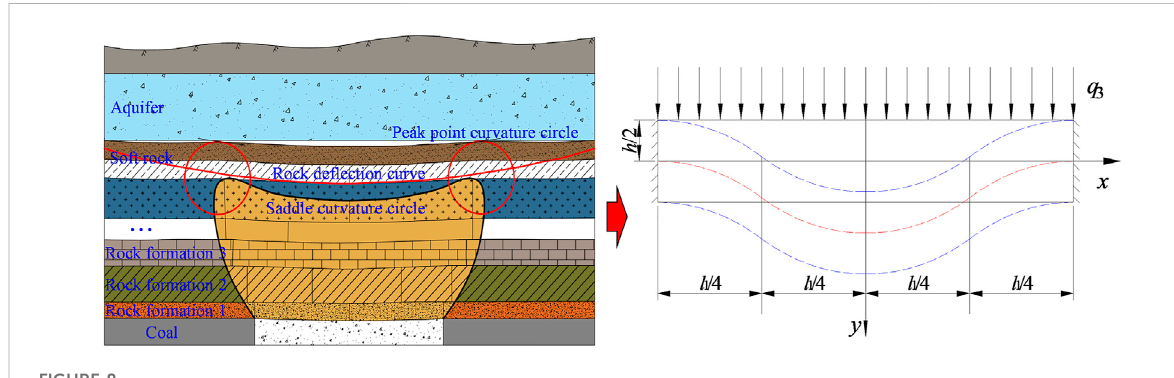
FIGURE 8 Mechanical model of solid support beam for overlying soft rock